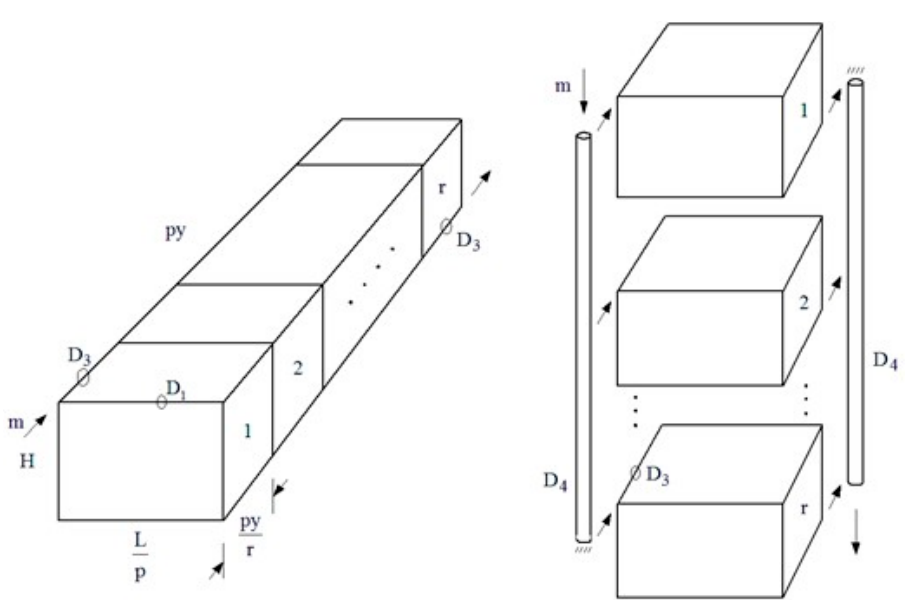
Figure 12. The modular flow architecture that approximates two trees matched canopy to canopy [133,134].